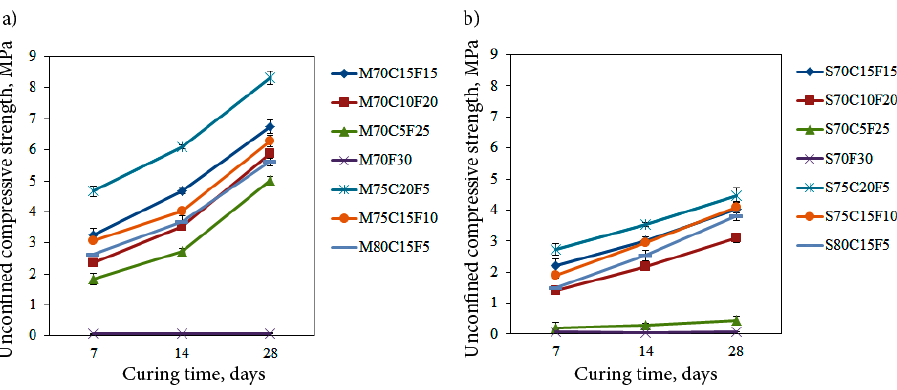
Fig. 3. Unconfined compressive strength of (a) S/S treated marine mud and (b) S/S treated